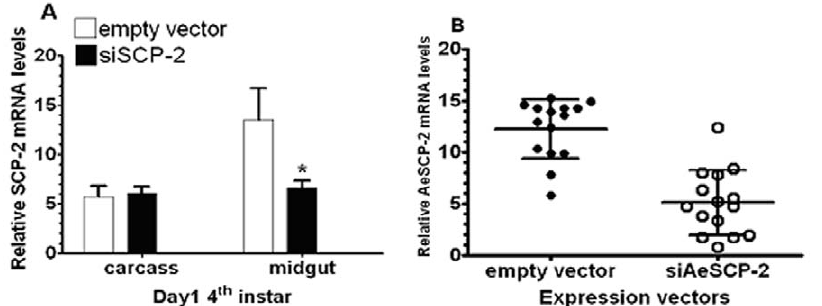
Figure 2. Tissue-specific transcriptional activities of the 2 1.6 kb AeSCP-2 construct and efficiency for driving siRNA expression in transfected larvae. ( A ) Expression knockdown of AeSCP-2 via the 2 1.6 kb AeSCP-2 promoter driven siRNA expression. Tissues were collected from the same larvae (10 larvae/sample). Mean and standard deviation are shown (N=3). ( B ) Fifteen synchronized 24 hour-old 4 th instar larvae were randomly selected and the total RNA was extracted from each individual larva. Mean and standard deviation are shown (N=15). Relative (vs. Actin-2 ) AeSCP-2 mRNA levels from each sample were determined via RT-qPCR. * Indicating significant difference (p , 0.05) from that of the empty vector